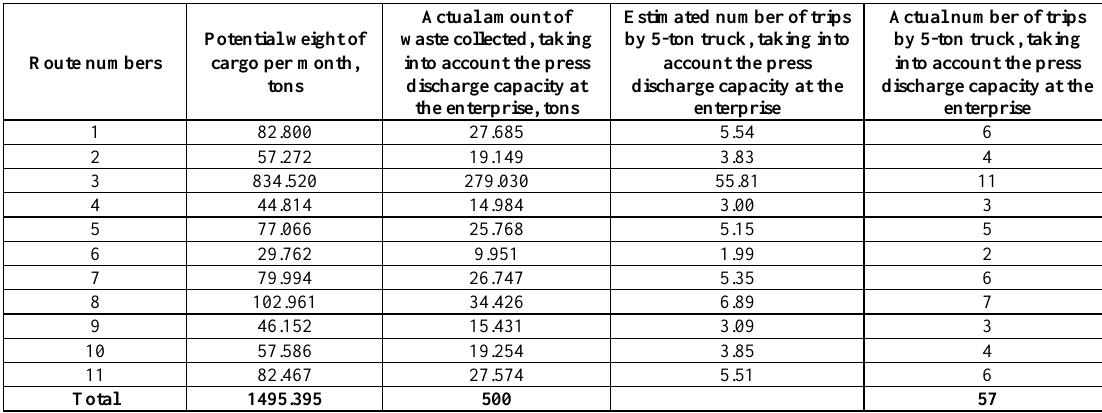
Table 2. Forecast of the number of trips by routes per